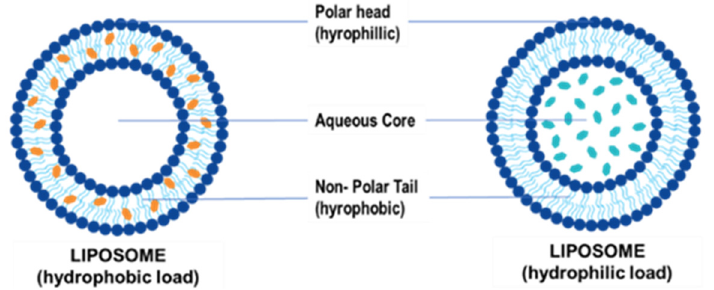
Figure 3. Illustration of a liposome and encapsulation of hydrophilic and hydrophobic